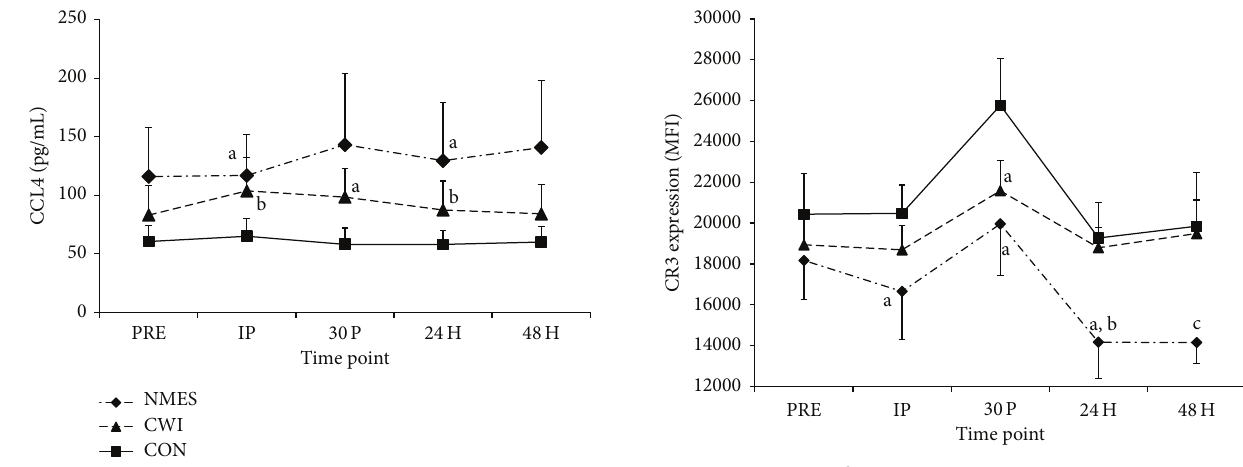
Figure2:CirculatingConcentrationofCCL4(mean ± SE).Changes in CCL4 concentration before exercise (PRE), immediately after exercise (IP), and 30 minutes (30 P), 24 hours (24 H), and 48 hours (48H) after exercise in neuromuscular electrical stimulation (NMES), cold water immersion (CWI), and control (CON) groups. (a) The value is “likely” greater than CON at the specified time point. (b) The value is “possibly” greater than CON at the specified time point.